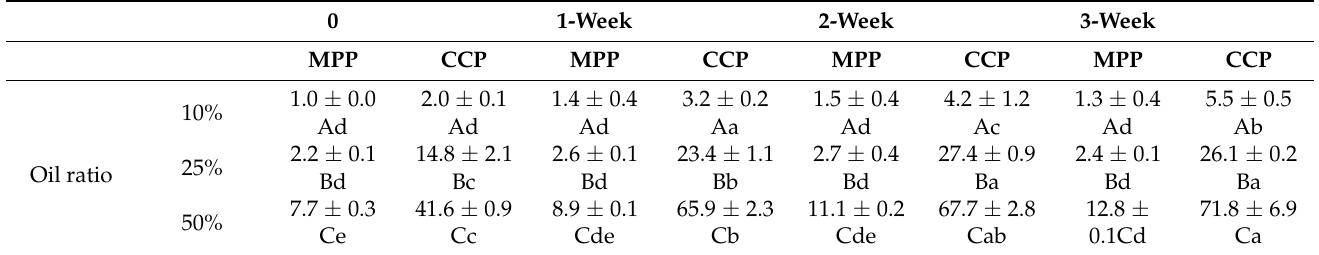
Table 6. The effect of different oil ratio on the average particle size (D 4,3 , µ m) of pectin